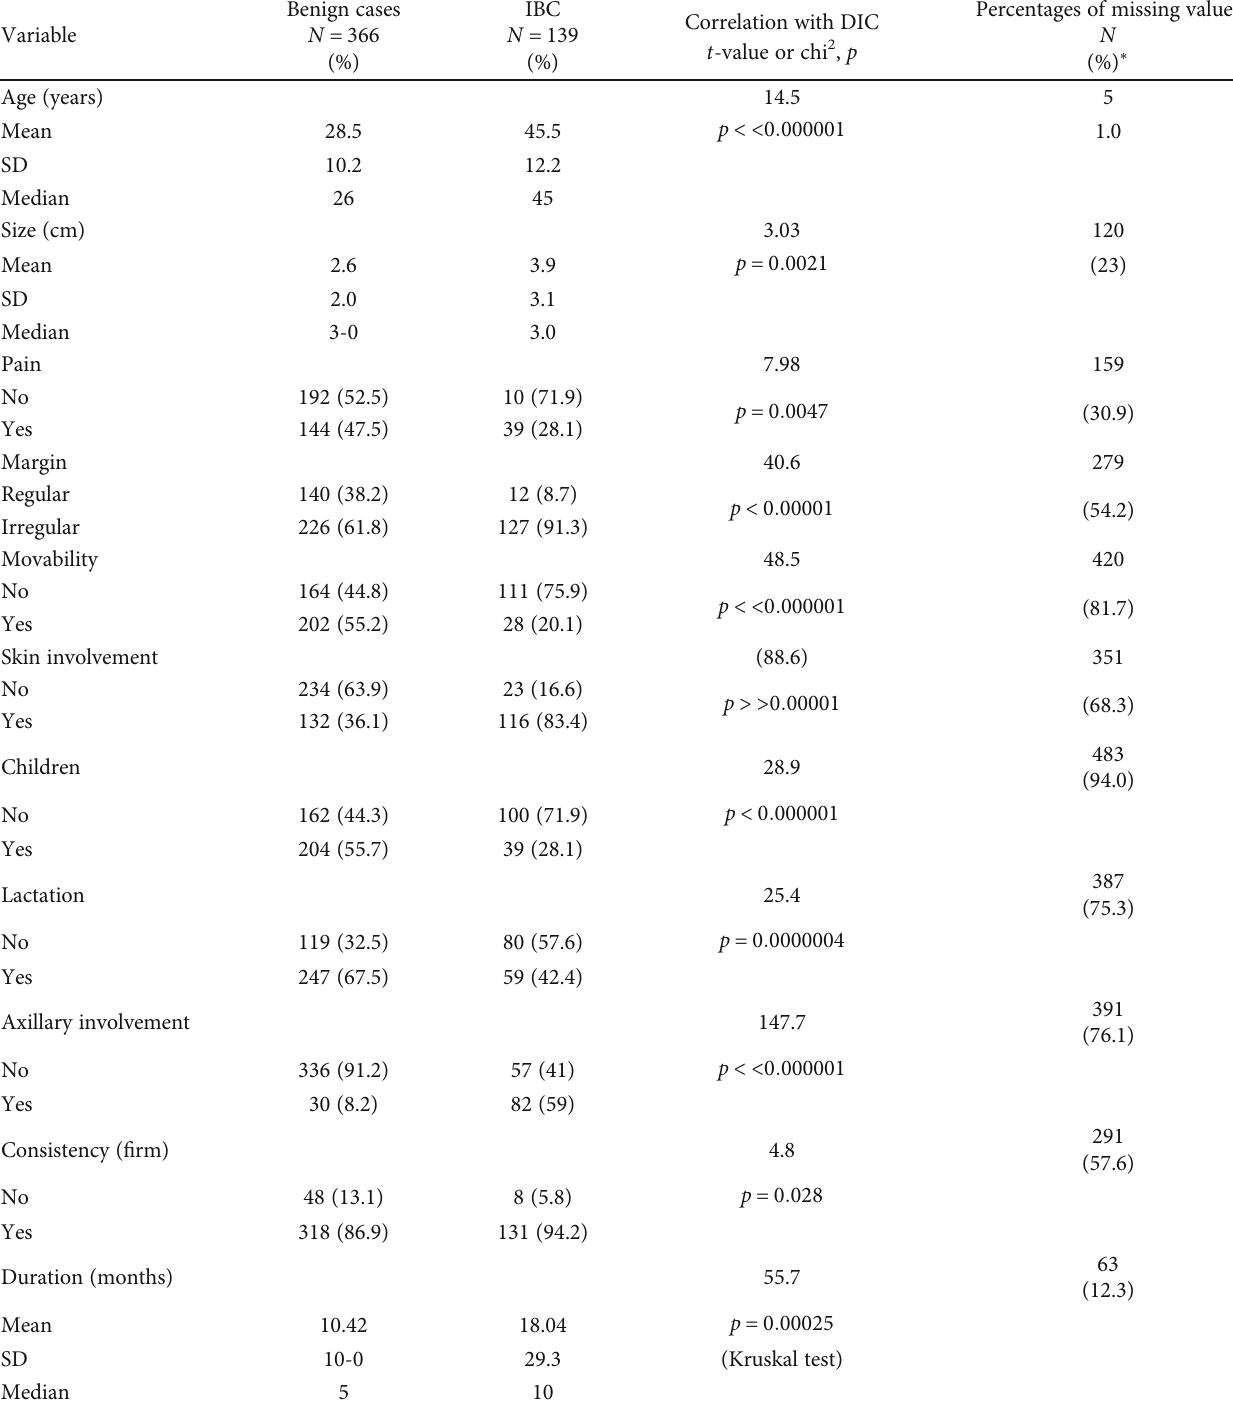
Table 1: Context variables and correlation in benign lesions versus invasive breast